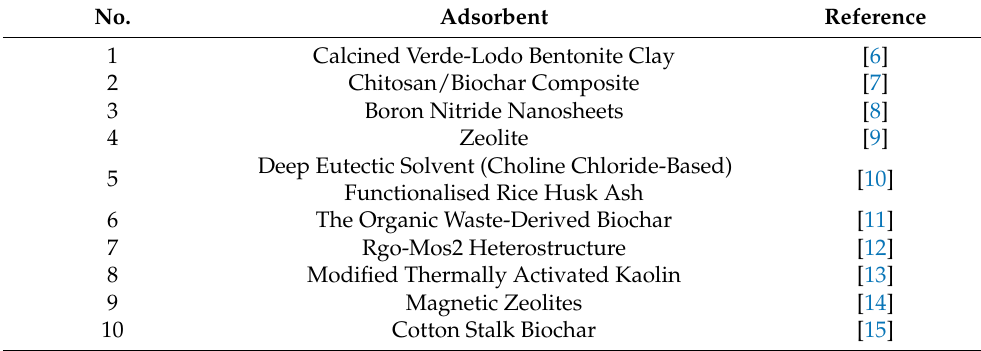
Table 1. List of researched adsorbents for ofloxacin adsorption from water. No. Adsorbent 1